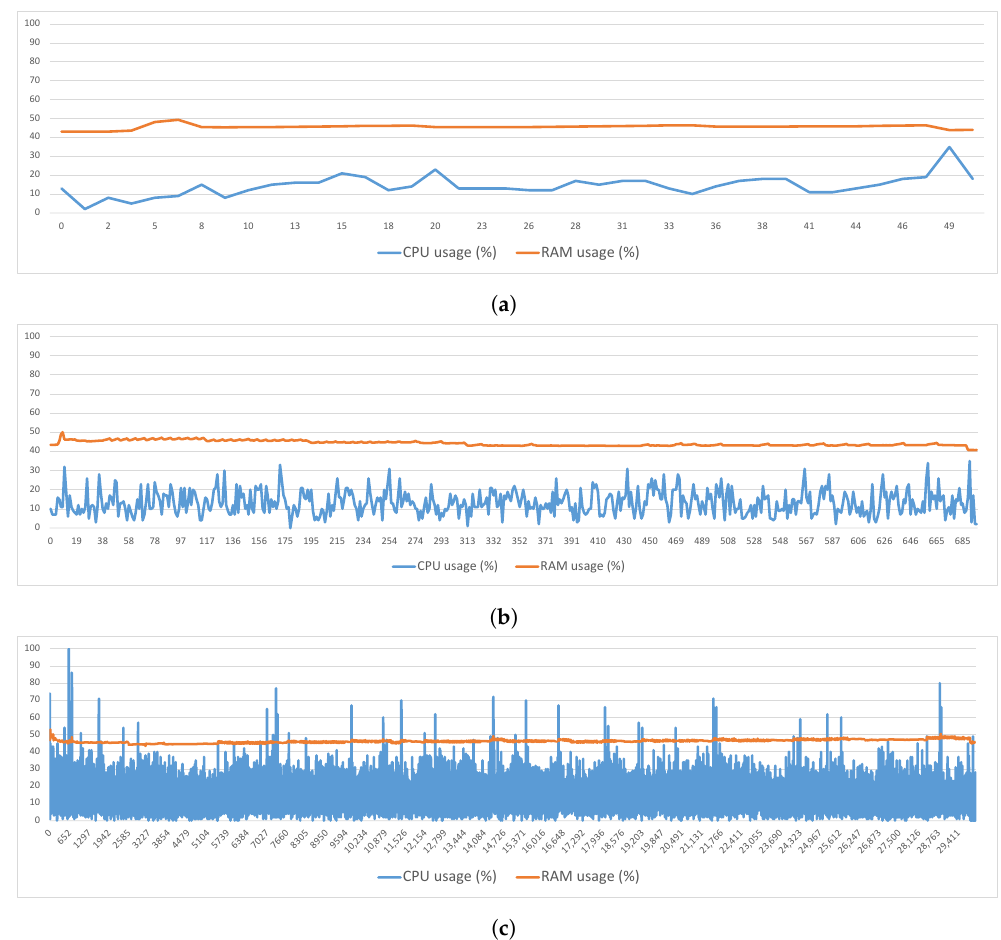
Figure 4. Shared Index Update—RAM and CPU Usage. ( a ) 1000 elements, ( b ) 10,000 elements, ( c ) 100,000